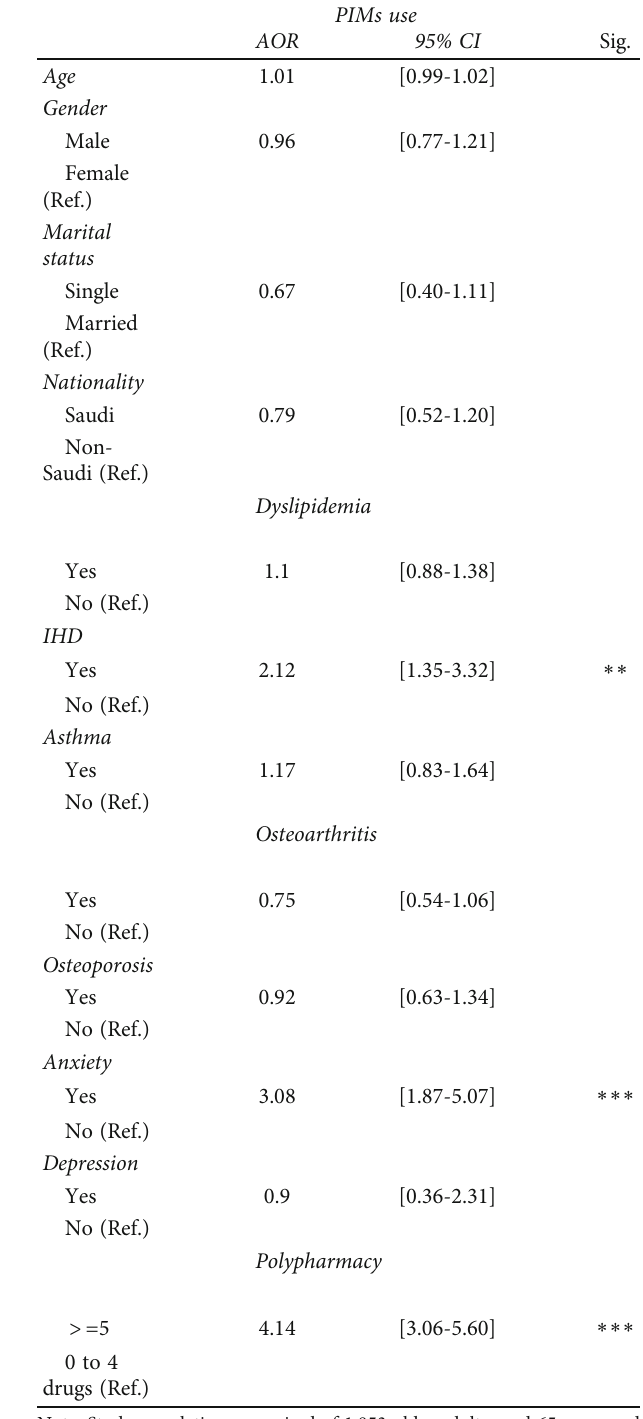
Table 3: Adjusted odds ratios and 95% con fi dence intervals. From logistic regression on PIM use among older patients with comorbid diabetes and